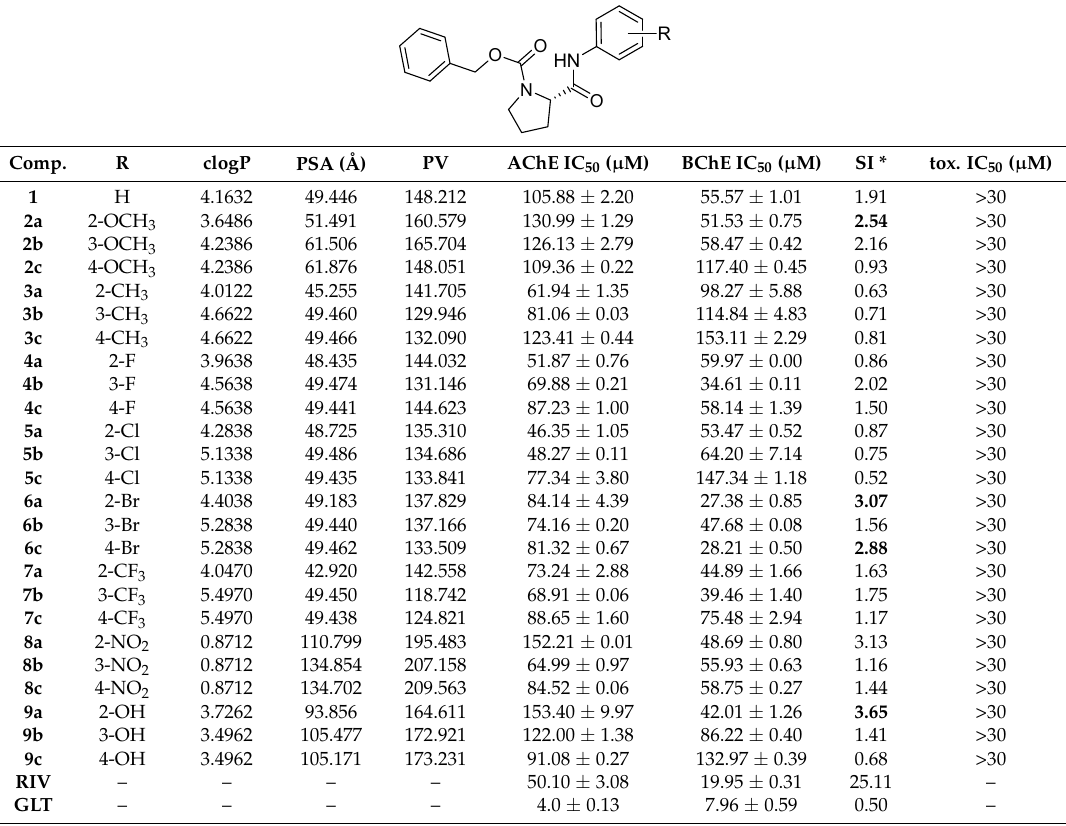
the concentration of inhibitor required for 50% inhibition of the mentioned enzymes. Table 1. Structures of discussed carbamates 1 – 9c ; calculated values of lipophilicity (clogP), polar surface area (PSA), polar volume (PV) and in vitro AChE and BChE inhibition (IC 50 ) in comparison with standards rivastigmine (RIV) and galanthamine (GLT) and in vitro cytotoxicity assay (IC 50 ) of compounds. ChE inhibitions are expressed as mean ± SD ( n = 3 experiments). O O HN N O